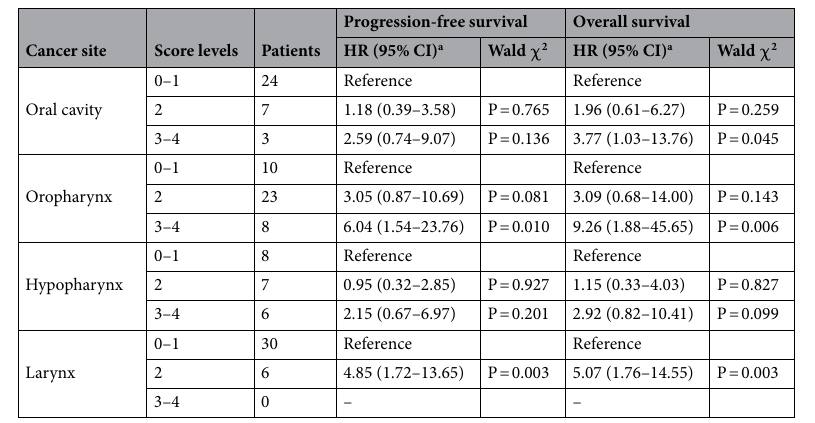
Table 5. Predictive score according separate cancer site. a Estimated through Cox proportional hazard